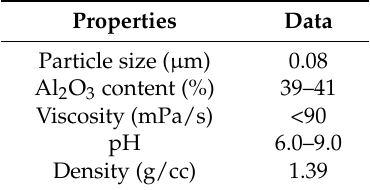
Table 2. Characteristics of fumed alumina stock solution used to prepare the colloid suspensions.